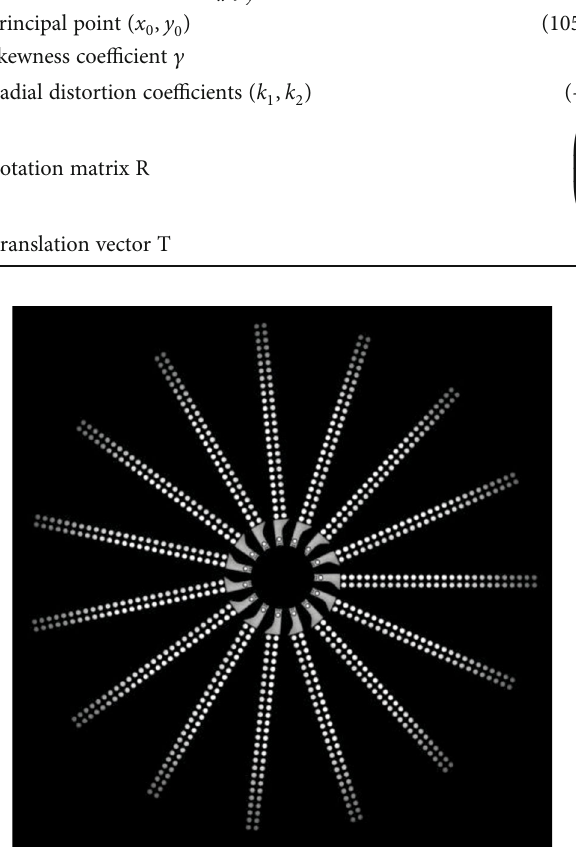
Figure 9: Unprocessed images of the measured blade at 15 azimuth locations, showing complete rotor disk at 2064rpm.